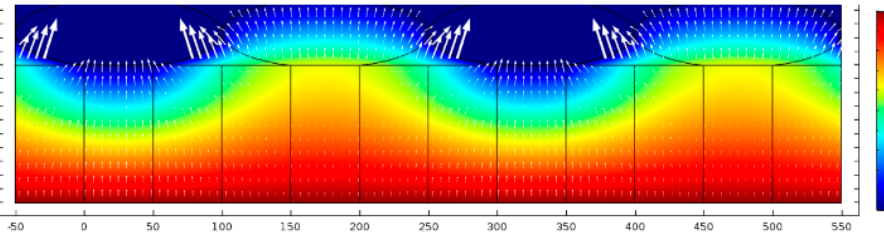
Figure 5. The contour plot of the electric field in the sensor structure in the horizontal direction.